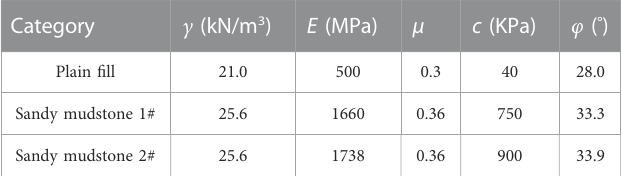
TABLE 4 Mechanical parameters of geotechnical